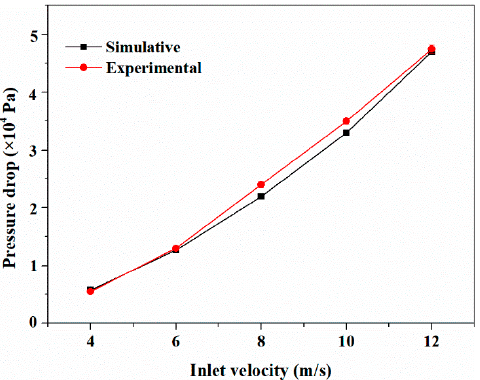
Figure 5. Comparison of simulated and experimental values of axial pressure drop in the mem- brane chamber. brane